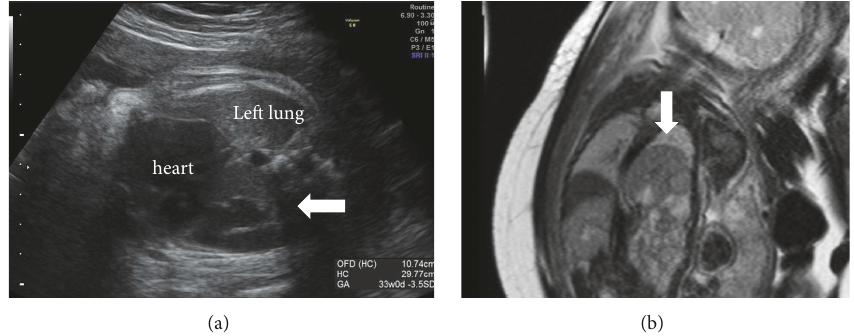
Figure 2: (a) Fetal echography showed a smooth-surface cystic lesion 29 × 44 mm in diameter in the left dorsal thorax (arrow) . (b) Magnetic resonance imaging at 37 weeks of gestation suggested left sac-type CDH. The stomach and spleen were herniated into the left chest (arrow)